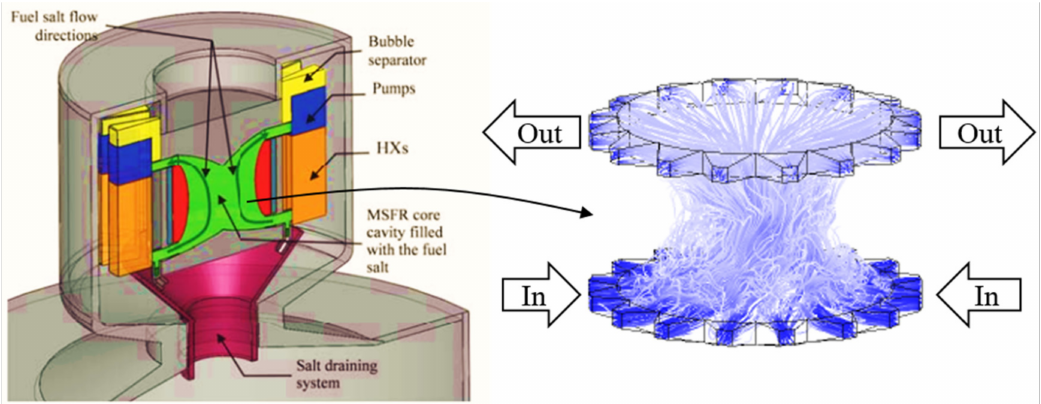
Figure 1. Core cavity of the Molten Salt Fast Reactor (MSFR) and representative flow field obtained for the liquid fuel in the core